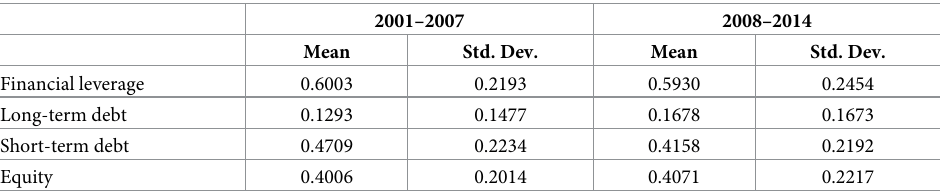
Table 2. Capital